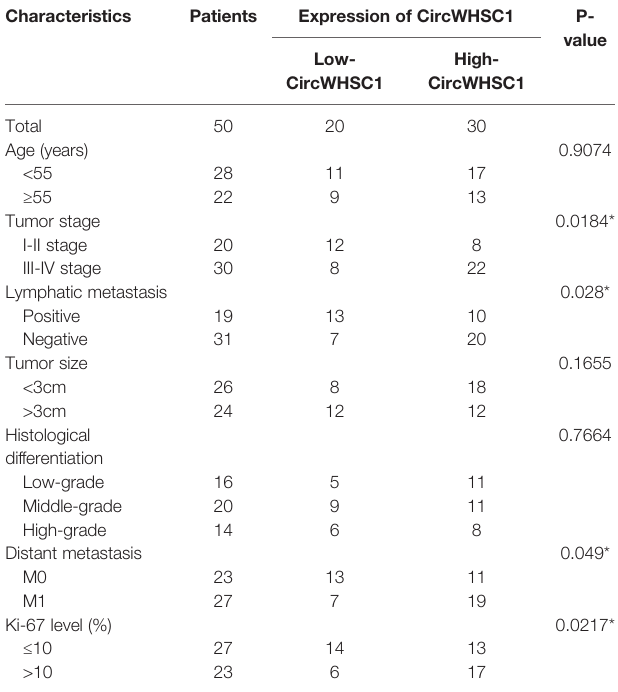
TABLE 1 | Relationship between CircWHSC1 expression level and clinical characteristics of BC patients.